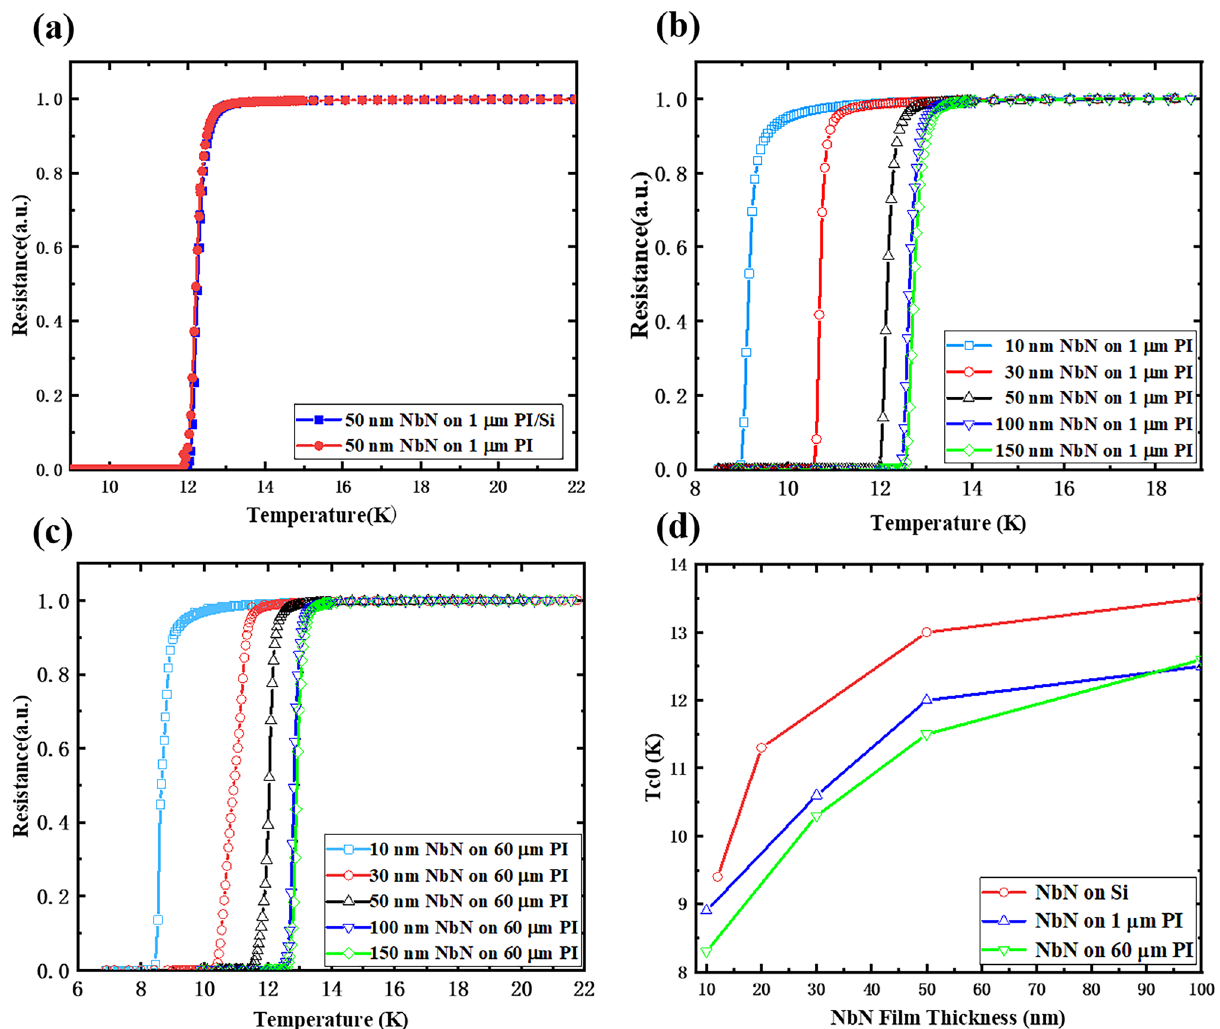
Figure 5. ( a ) R-T curves of 50 nm NbN films on 1 μm PI with and without Si substrate. ( b ) R-T curves of NbN films with different thicknesses on 1 μm PI. ( c ) R-T curves of NbN films with different thicknesses on 60 μm PI. ( d ) T C0 of NbN films with different thickness on PI and on Si